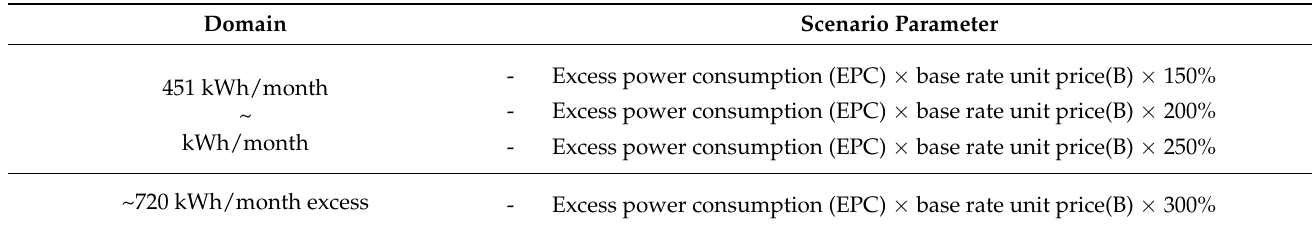
Table 5. Criteria For Applying a Contract Power Excess Charge